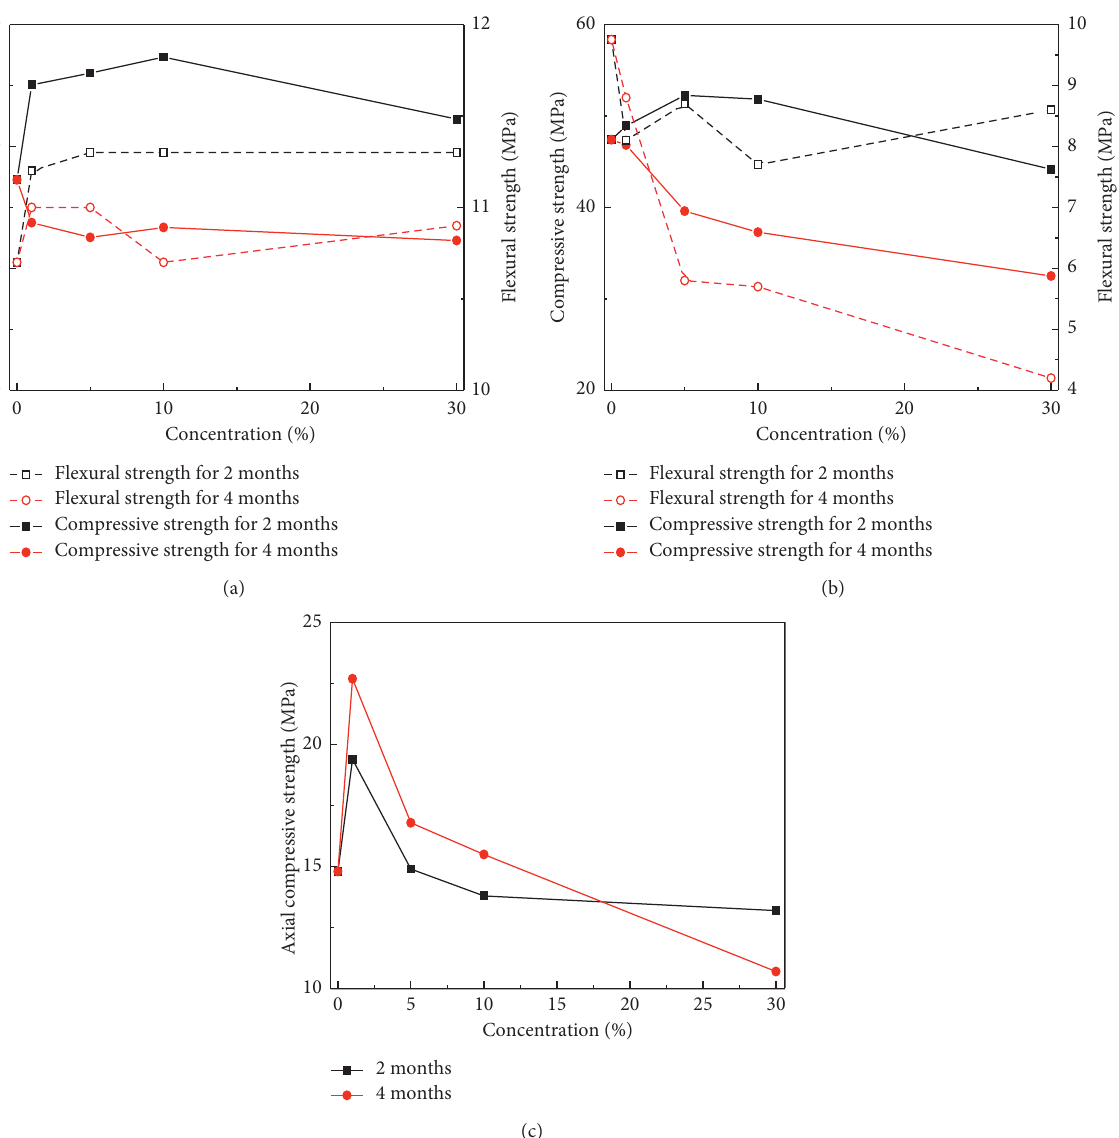
Figure 8: Mechanical properties of different specimens attacked by sulfate solution. (a) Paste. (b) Mortar. (c)